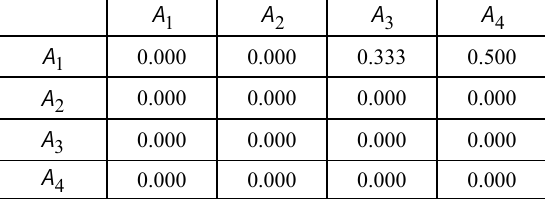
Table 14. Preference degree with respect to criterion